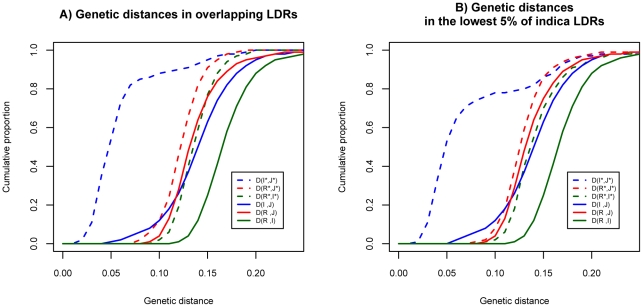
Distributions of genetic distances between populations in the genomic background and LDRs.A) The cumulative distributions at overlapping LDRs (dashed curves) and genome background (solid curves). B) The cumulative distributions at bottom 5% of LDRs in indica (dashed curves) and genome background (solid curves). We use R for O. rufipogon, I for indica and J for japonica to indicate the genomic background. Overlapping LDRs (in panel A) or bottom 5% of LDRs (in panel B) in these species are designated by I*, J* and R* respectively.